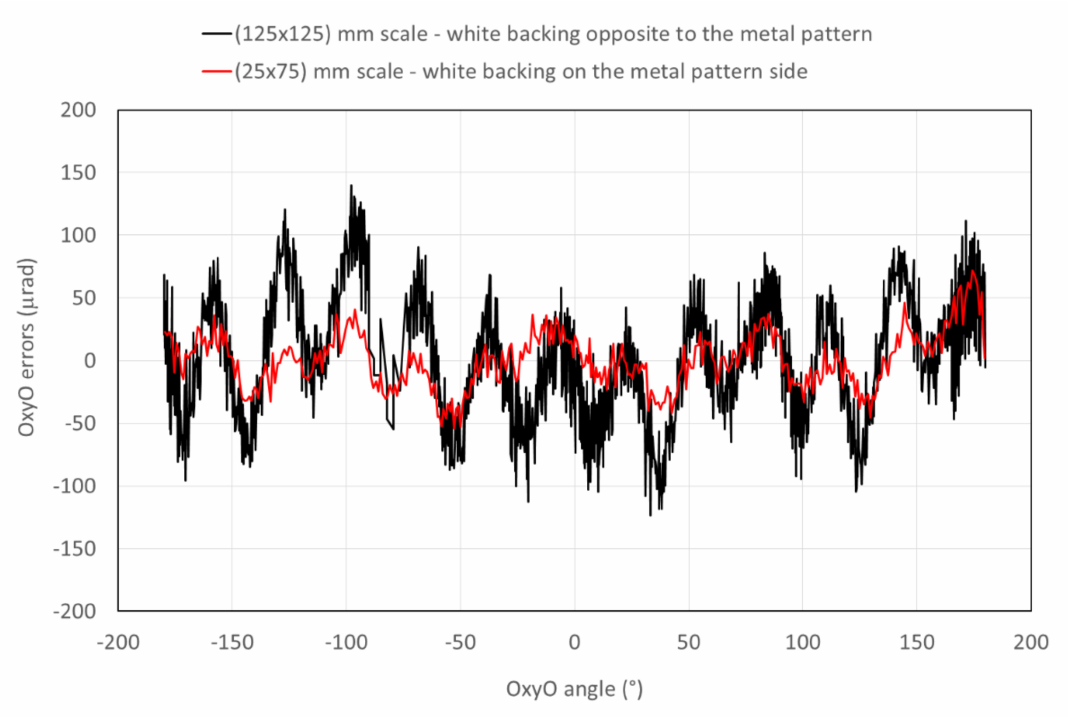
Figure 4. Di ff erences between angular values measured by OxyO system and REAC.